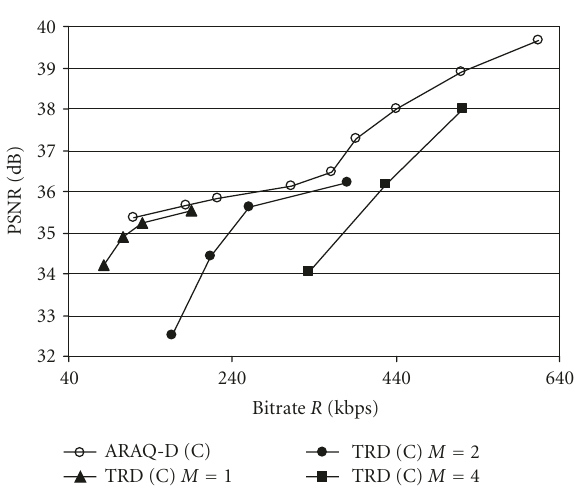
Figure 12: R-D curves for the Mother-Daughter (D) sequence obtained with the ARAQ-D technique, compared to the perfor- mance of a TRD